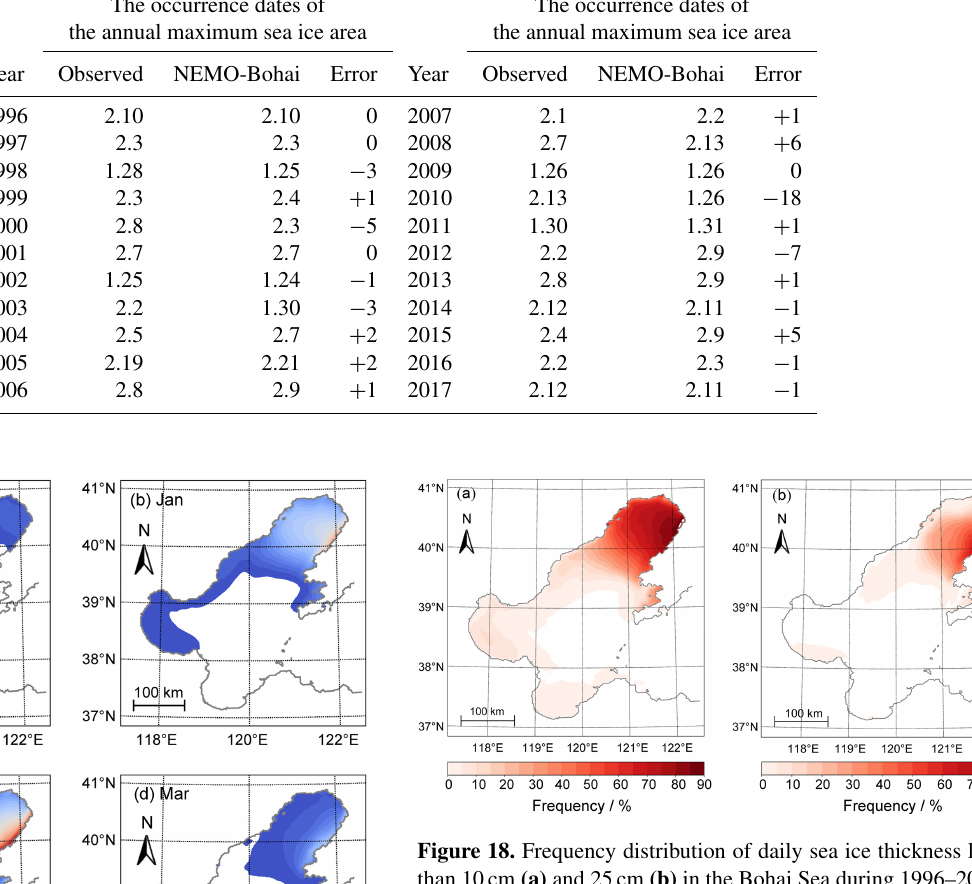
range of 0.1–73 . 0 × 10 8 m 3 , which agrees with the range of 4.4–63 . 0 × 10 8 m 3 reported by Liu et al. (2013) based on AVHRR satellite images. However, it is noticeable that there is a lag in modelling sea ice formation during the early freez- ing period compared to satellite observations. Results of model comparison with in situ data and satellite-derived data confirm the robustness of the developed model, which allows us to use it in a more detailed evalua- tion of the spatial and temporal changes of Bohai Sea ice and study the continuous processes of freezing and melting at daily